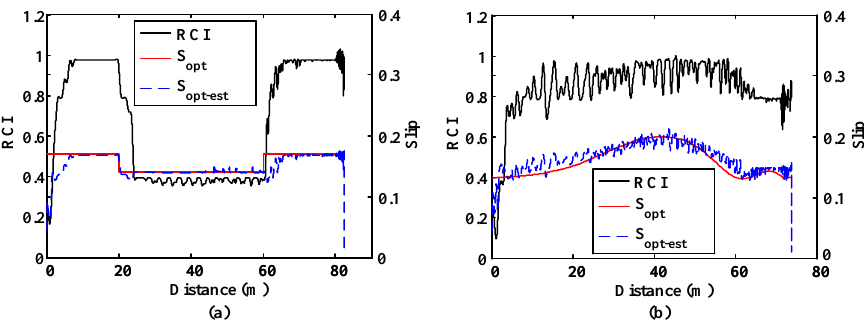
Figure 14. Road condition estimation and optimal slip comparison. ( a ) Straight line simulation. Surface transition: 20 m. on µ = 1, 40 m. on µ = 0.4 and 40 m. on µ = 1; ( b ) Curve simulation. Surface µ = 0.8. 500 m. radius curve.